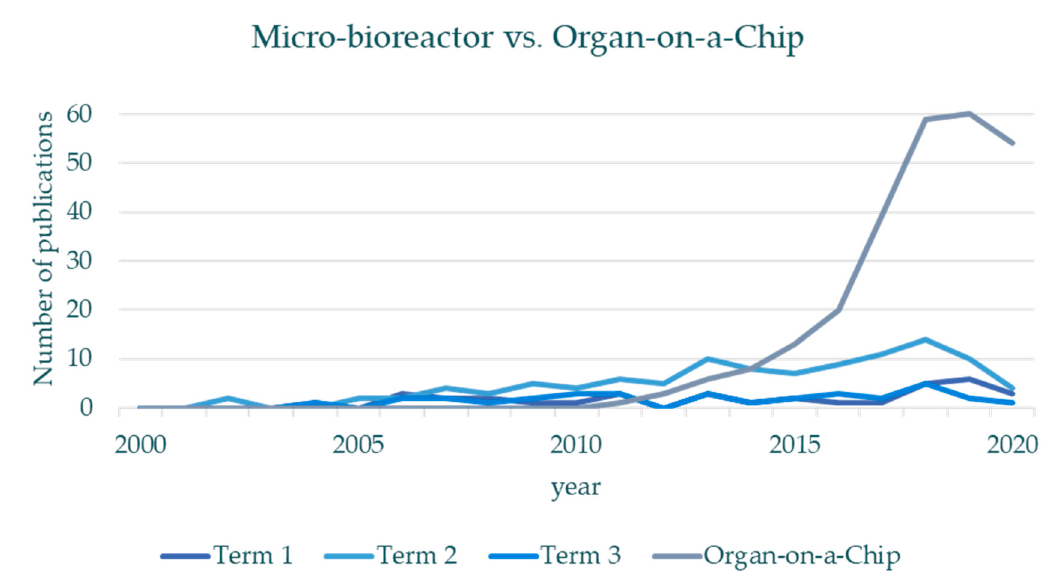
Figure 9. Search results in the database PubMed between 2000 and 2020 with the search terms 1–3 used in this review for micro ‐ bioreactors (Term 1: 3D cell culture” AND “microbioreactor; Term 2: (bioreactor OR microbioreactor OR micro ‐ bioreactor) AND (“three ‐ dimensional cell culture” OR “3D cell culture” OR “3 ‐ D cell culture”); Term 3: (microbioreactor OR micro ‐ bioreactor) AND “tissue engineering” compared to organs ‐ on ‐ a ‐ chip (search term: (“organ on chip” OR “organ ‐ on ‐ chip” OR “organ on a chip” OR “organ ‐ on ‐ a ‐ chip”) AND (“tissue engineering” OR “three dimensional cell culture” OR “3d cell culture” OR “3 ‐ d cell culture”), status as per 27 October 2020).